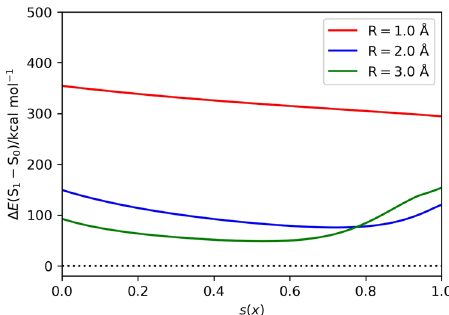
Fig. 3 The S 1 − S 0 energy gap of the instantaneous Hamiltonian H ( s ( x )) of N 2 molecule with the bond lengths R(N − N) = 1.0, 2.0, and 3.0 Å. The Δ E (S − S s ( x ) = 0.0 and 1.0 corresponds to the energy gap of 1 0 ) values at the Fock operator and the full electronic Hamiltonian,